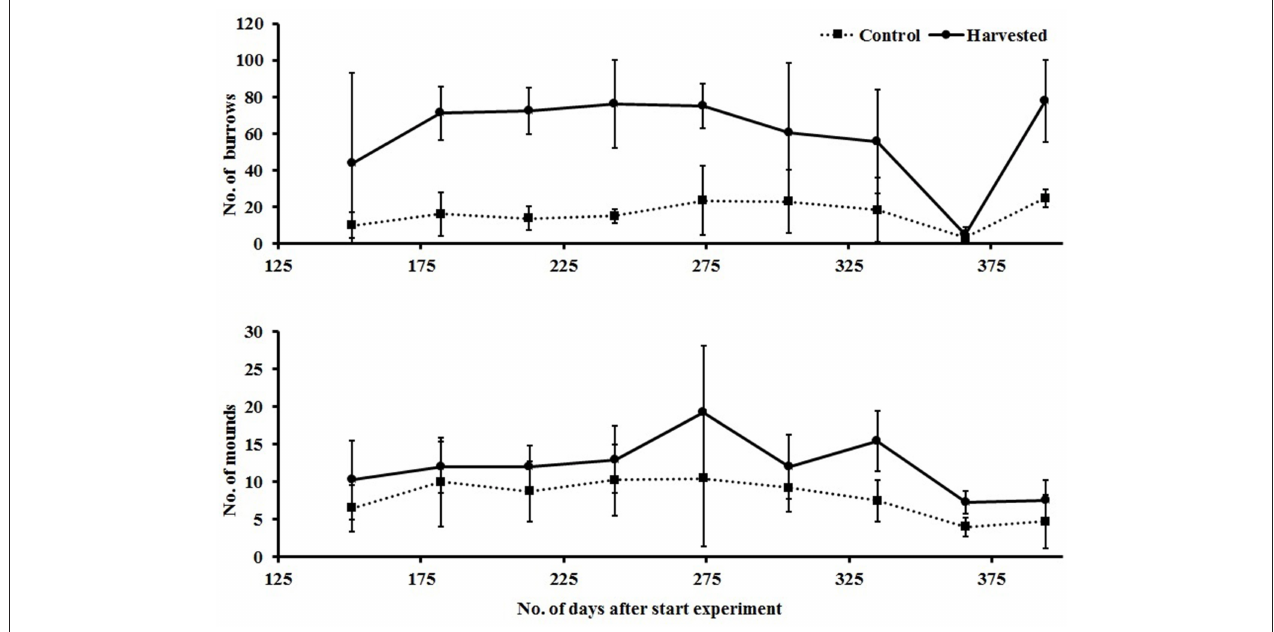
FIGURE 10 | Mean ( ± 95% CI) counts of burrows (top) and mounds (bottom) visible in plots, recorded as evidence of bioturbation by large bodied epi and